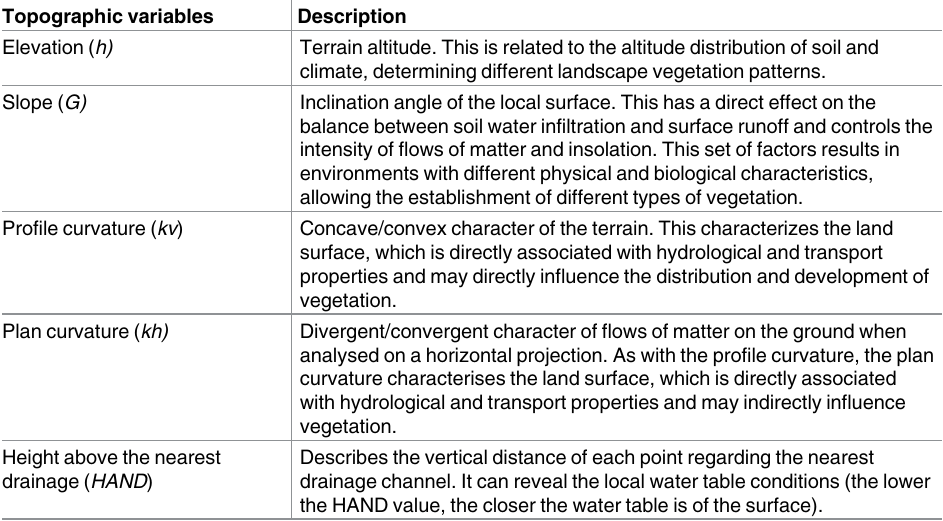
Table 1. Definitions of the topographic variables used in this study. Topographic